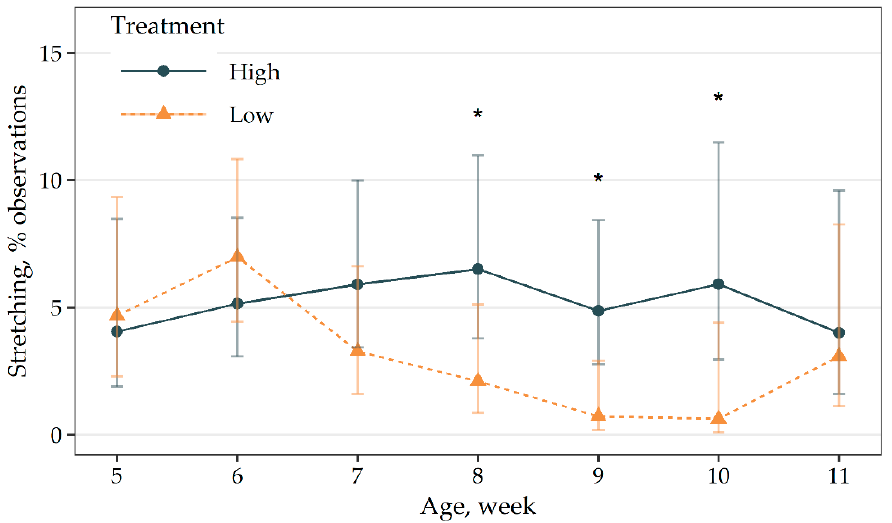
Figure 3. Means ( ± 95 CI) of stretching events for outdoor stocking density treatment (high: 0.5 m 2 of pasture per bird; low: 2.5 m 2 of pasture per bird) and age interaction effect. * = means within a week are different after Tukey’s adjustment, p ≤ 0.03.